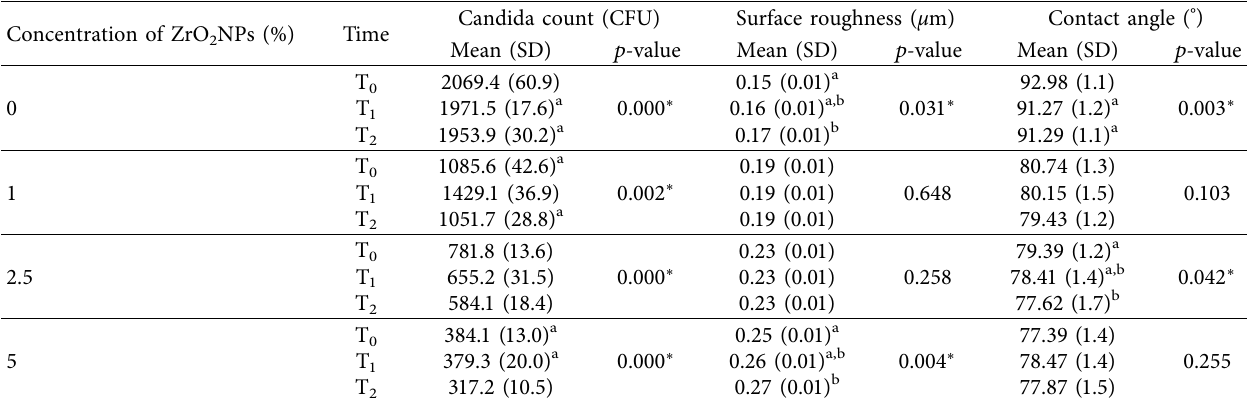
Table 2: Means, standard deviations, and p -values for heat-polymerized specimens modified with different concentrations of ZrO according to concentration.